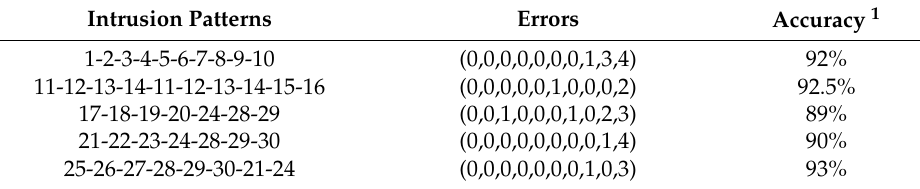
Table 5. Intrusion pattern discovering results.